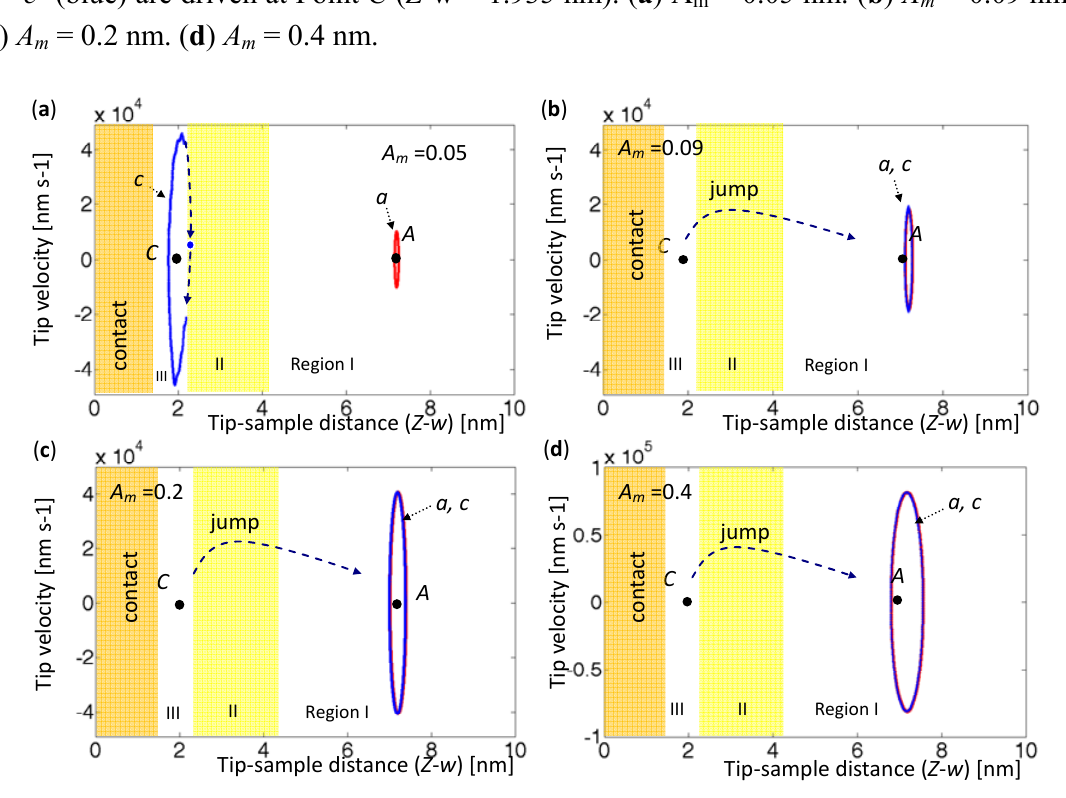
= 0.05 nm. ( b ) A = 0.09 nm. m m